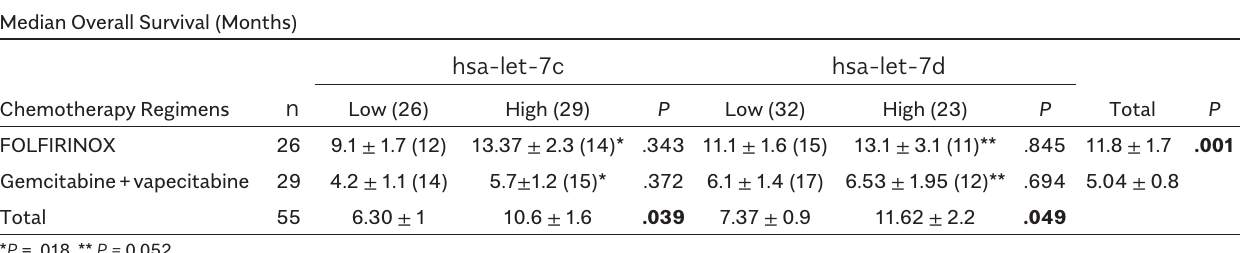
Table 1. The Relationship of Pancreatic Cancer Median Overall Survival for High- and Low-Level Serum let-7c and 7d with FOLFIRINOX and Gemcitabine + Capecitabine Treatment Groups Median Overall Survival (Months)